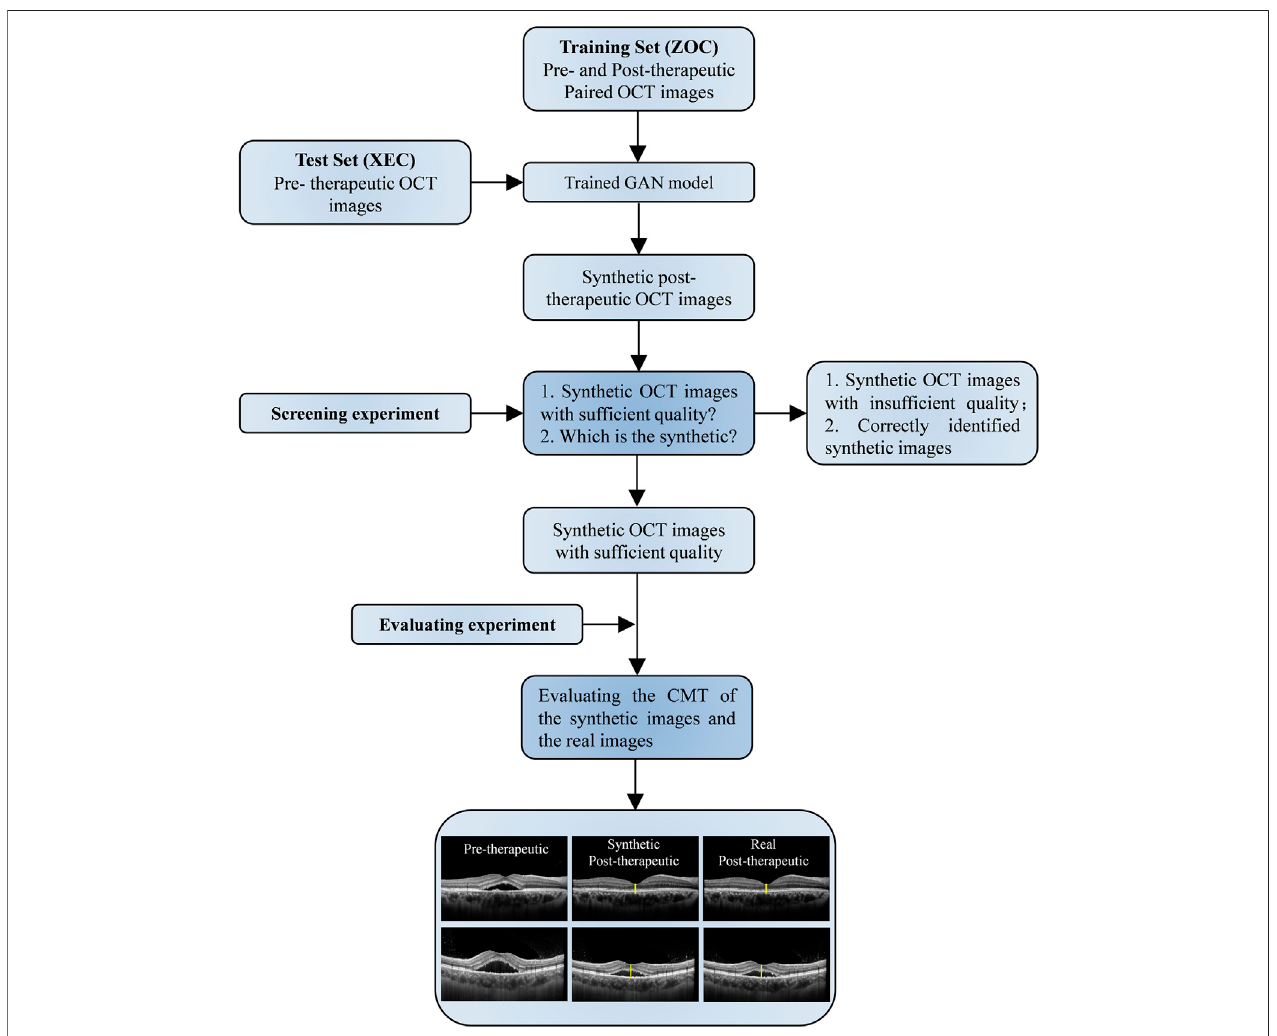
FIGURE 3 | Work fl ow diagram of the synthetic OCT generation and evaluation. GAN, generative adversarial network; nAMD, neovascular age-related macular degeneration; OCT, optical coherence tomography.